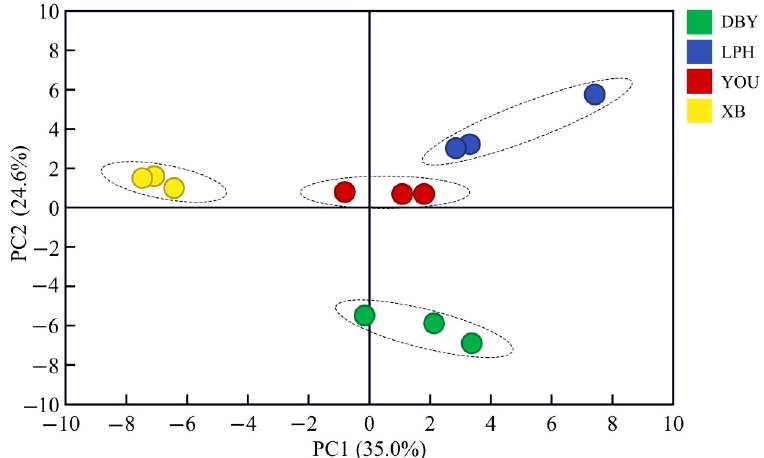
Figure 3. Partial least square discrimination analysis (PLS-DA) of volatile compounds in four different apricot cultivars. DBY, Dabaiyou apricot; LPH, Luopuhongdaike apricot; YOU, You apricot; XB, Xiaobai apricot.